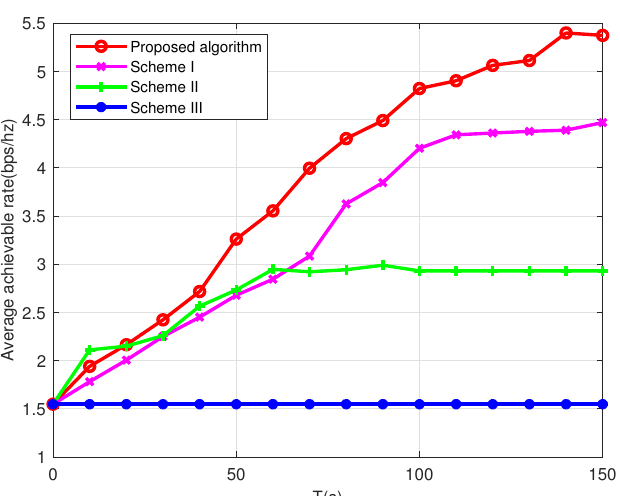
Figure 8. The average achievable rate for multi-UAV scenario in different